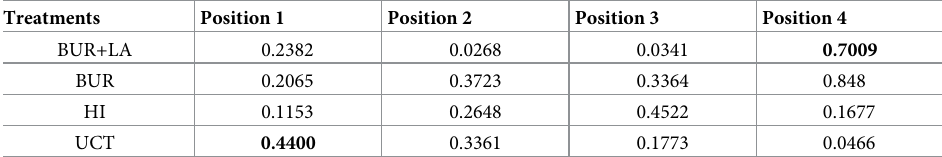
Bold values are the highest values in the selected columns.